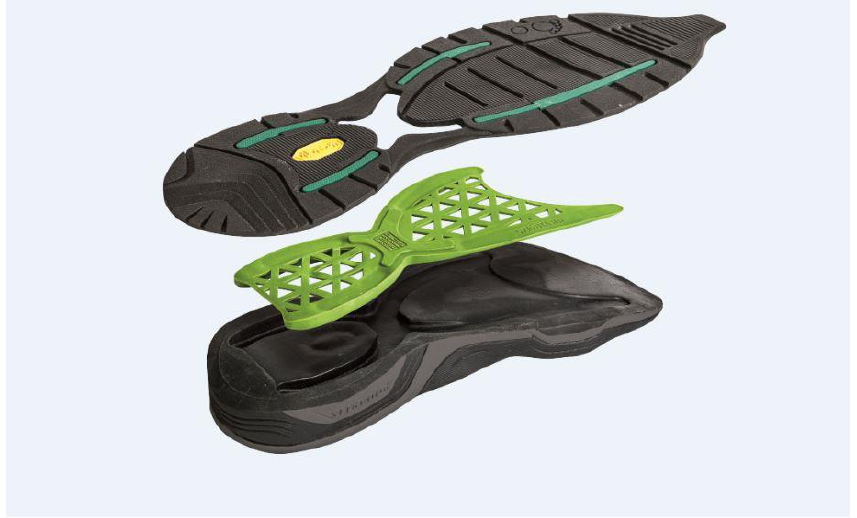
Figure 2. Details of the sole of the obesity-specific shoes used in the study.